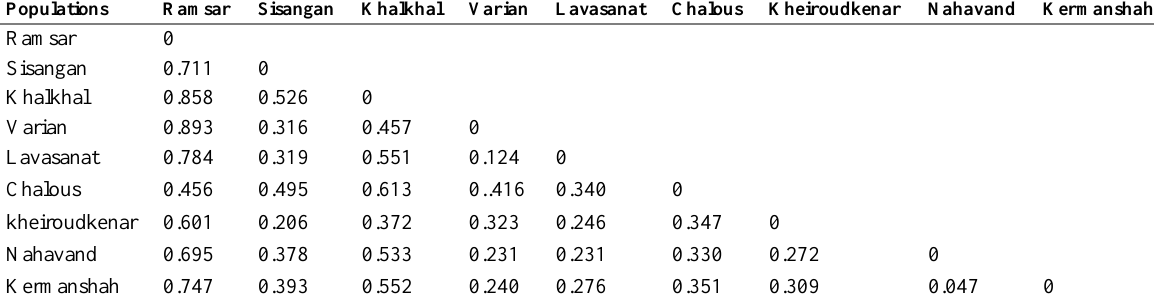
Table 7. The distance among 9 studied populations of wild violet. Populations